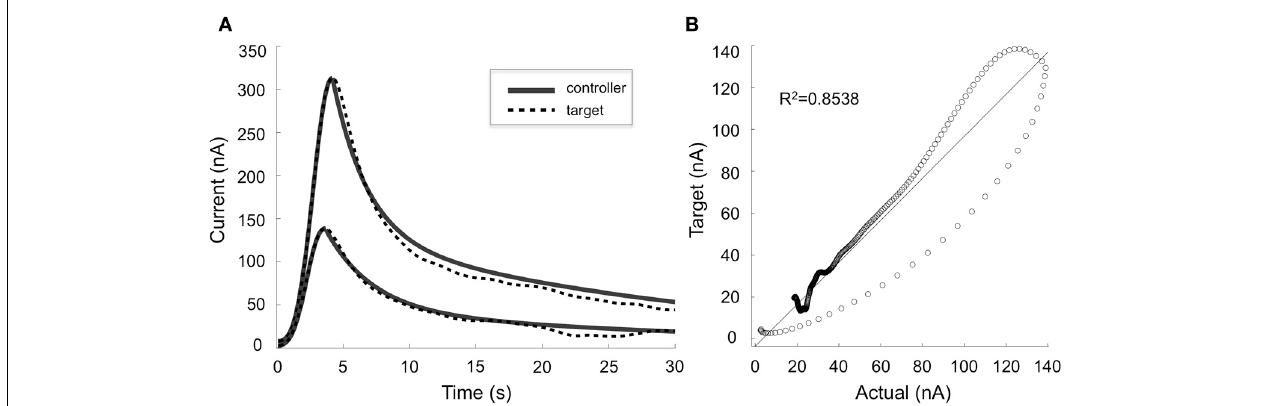
FIGURE 4 | Controller performance. (A) Comparison of target (dotted lines) and actual (solid lines) dopaminergic responses evoked by stimulation parameters predicted by the artificial neural network